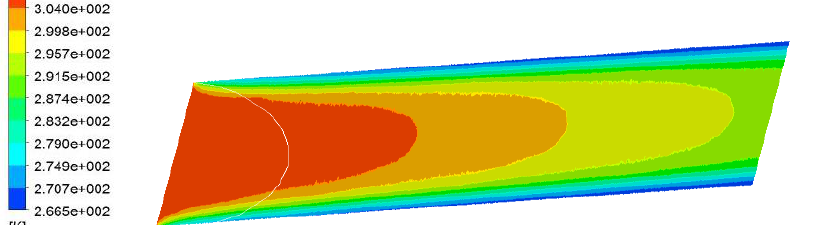
Fig. 3. Evolution of the working fluid temperature at Re